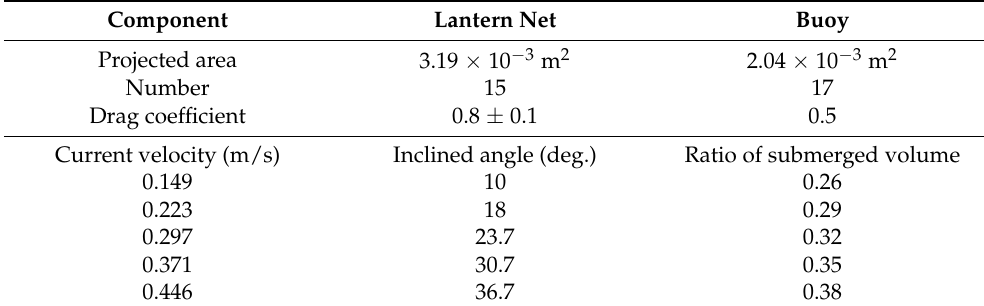
Table 3. Information of the lantern net and buoy of the longline aquaculture facility with lantern nets in the calculation of tension mooring in the current conditions.